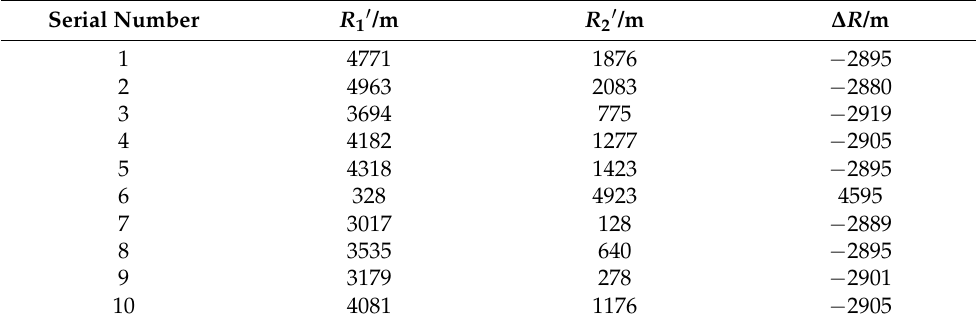
Table 3. The position of false alarm signal under ∆ f j 1 = 0.02 kHz and ∆ f j 2 = 3.92